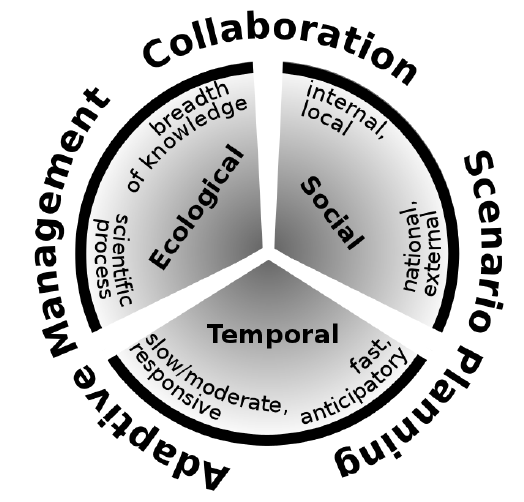
Fig. 6 . Three types of complexity face land